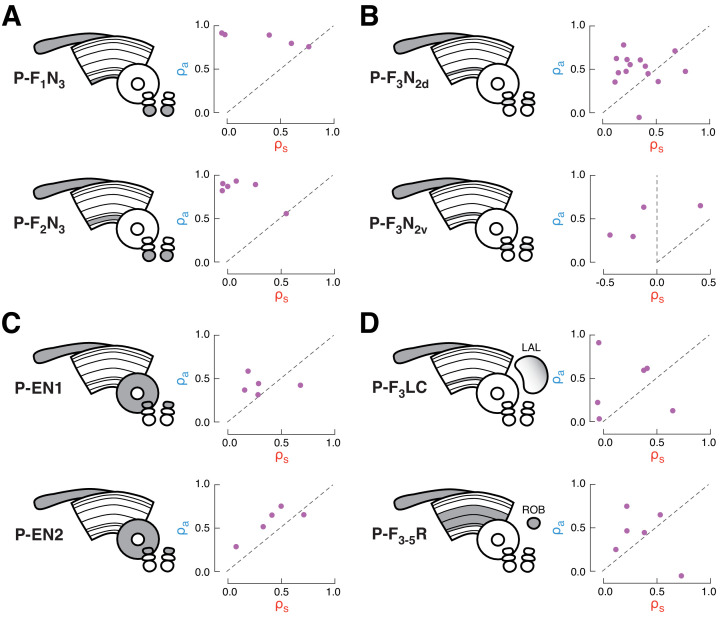
Characterization of multi-sensory integration for recorded cell types.Each plot shows the similarity (correlation coefficient) of the response to airflow + stripe with the response to airflow alone (y-axis) versus stripe alone (x-axis), as in Figure 2 and 3. Each point represents the coefficient for one fly, calculated from the mean firing rate timecourses for all four stimulus directions. Data along the diagonal indicates that the multi-sensory response is equally similar to the stripe alone and airflow alone responses, a hallmark of summation. Data above the diagonal indicates that the multisensory response more closely resembles the airflow response and data below the diagonal indicates that the multisensory response more closely resembles the stripe response. (A) Ventral P-FNs, P-F1N3, and P-F2N3, consistently possess high airflow coefficients, indicating that the multi-sensory response is dominated by the airflow response. (B) Dorsal P-FNs, P-F3N2d, and P-F3N2v, show diverse coefficients, indicating diverse integration strategies across cells. P-F3N2v neurons even exhibit strong negative coefficients (left of vertical dashed line), indicating that the multi-sensory response can resemble inverted single modality responses. (C) P-ENs. P-EN1 integrates variably across cells, while P-EN2 integration is more consistent, as discussed in Figure 2. (D) CX extrinsic columnar neurons. Integration across P-F3LC and P-F3-5R neurons was the most variable among recorded cell types.